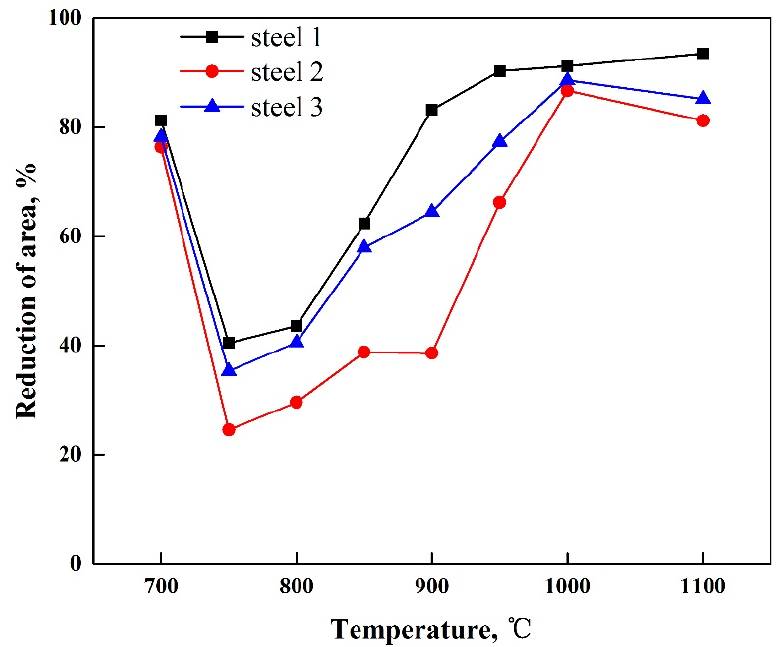
Figure 2. RA values of the steels tensile ‐ tested at different temperatures between 700 and 1100 °C.